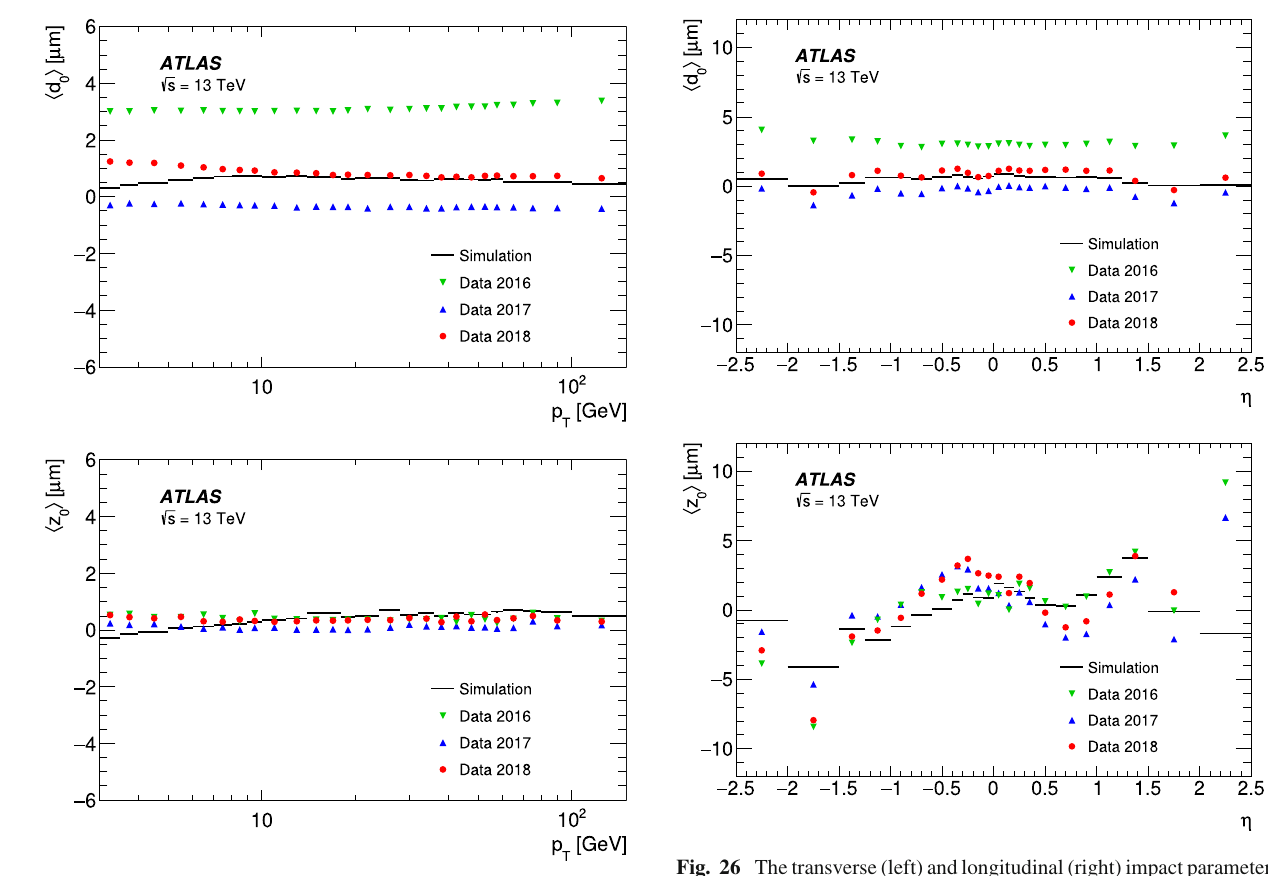
Fig. 25 The transverse (left) and longitudinal (right) impact parameter biases as function of the track p T . The 2016 data entries in this figure are taken from the second part of the 2016 data visible in Fig. 24; the first part of the 2016 data also show no impact parameter dependence on track p T